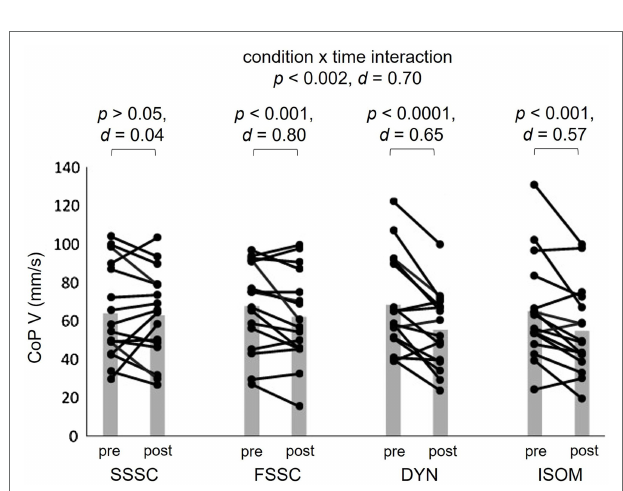
FIGURE 3 | Mean value (grey bar) and individual scores of the center of pressure velocity pre- and post-intervention. DYN, dynamic strength exercise; ISOM, isometric strength exercise; SSSC, slow stretch-shortening cycle exercise; FSSC, fast stretch-shortening cycle exercise; CoP V, center of pressure velocity; d, Cohen’s d.